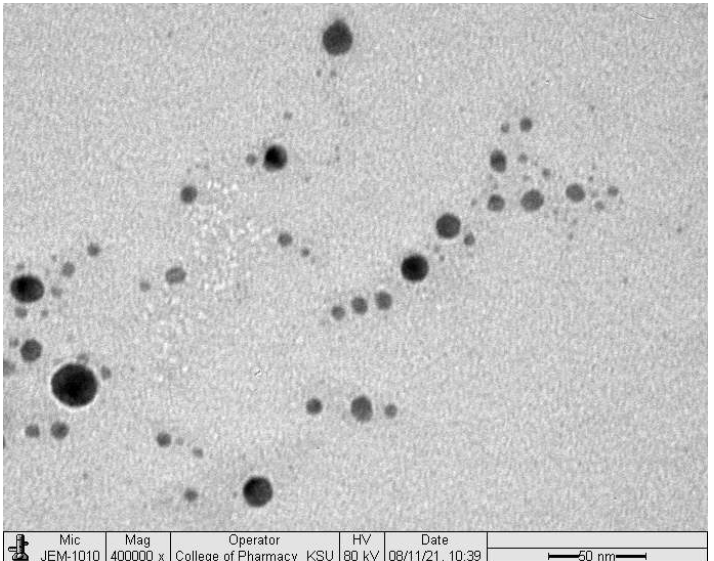
Figure 1. Transmission electron microscope image of the prepared SNEDDS formulation.